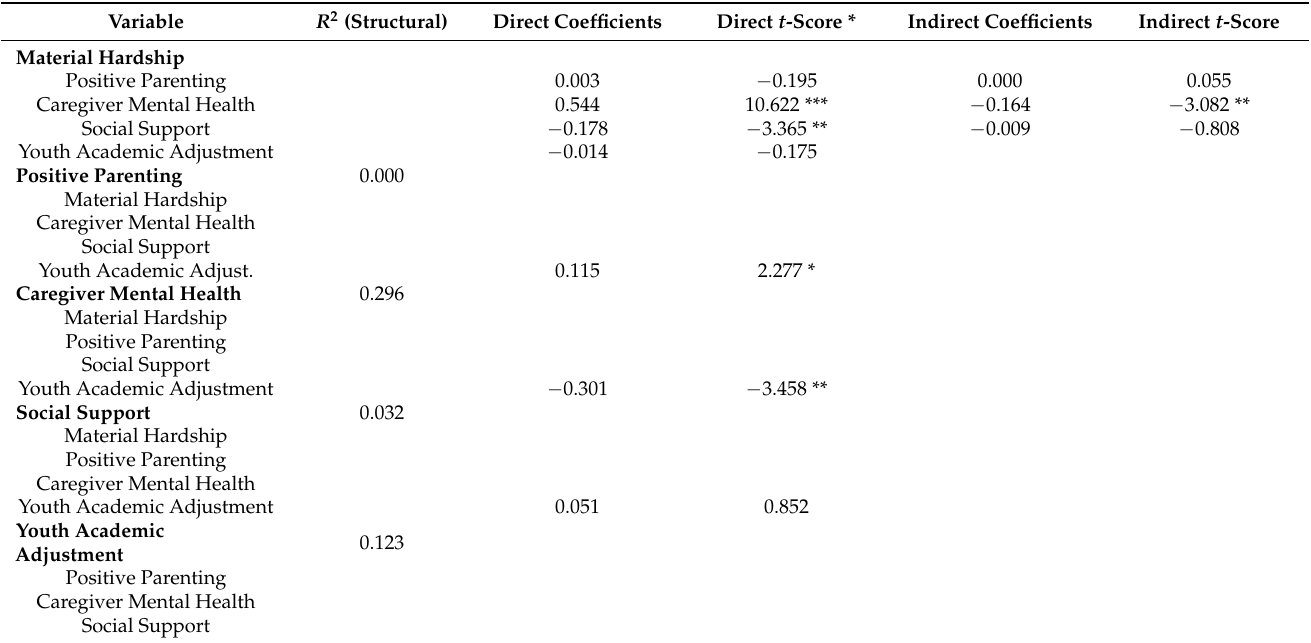
Table 4. Structural Model Standardized